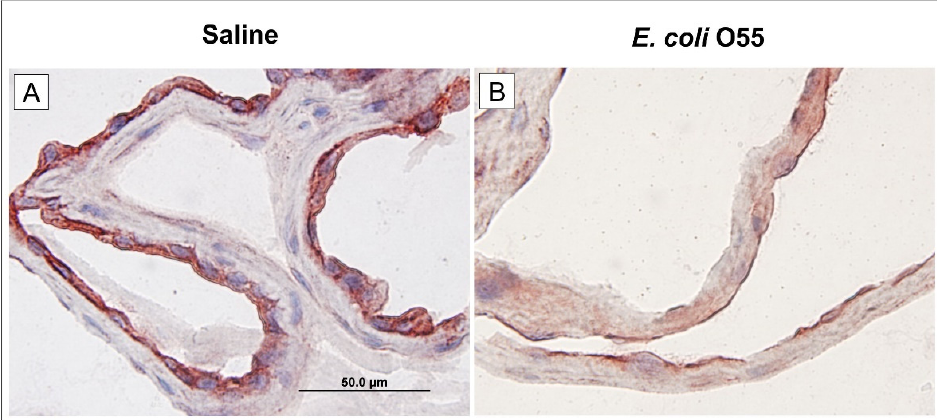
Figure 3. Expression of RAGE on amniotic membrane. Expression of RAGE in the amniotic membrane of the saline-treated ( A ) and E. coli O55-infected ( B ) amniotic membrane are depicted on group representative micrographs. A bar ( A ) corresponds to 50 µ